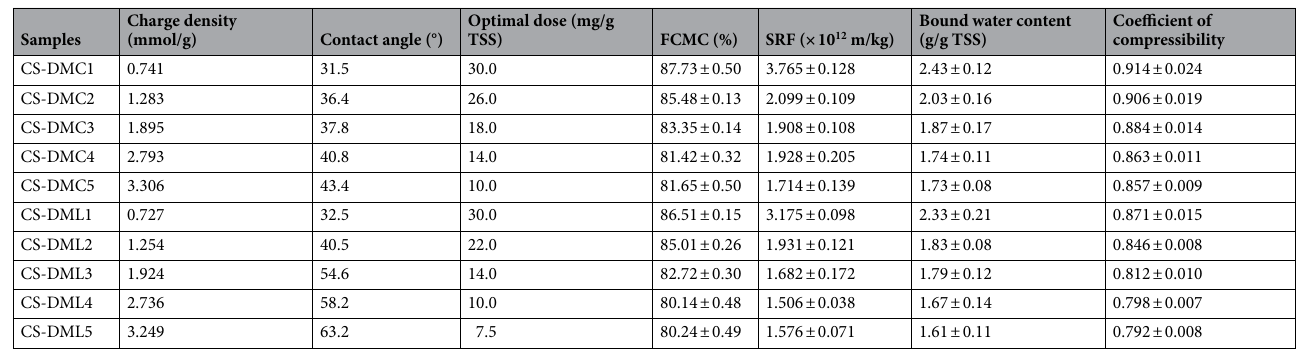
Table 1. The structural parameters of various St-based flocculants and its dewatering